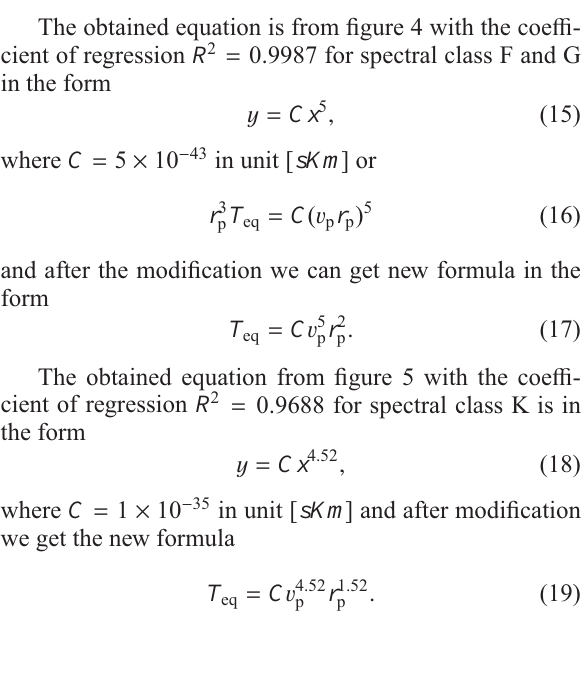
Fig. 3. Dependence of the parameters r p T e ff , r p L ,and r p J on v p r p for the stellar spectral class K. According to the regression anal- ysis, the best is the power interpolation with the coe ffi cient of determination R 2 = 0 . 776 for the parameter r p T e ff .